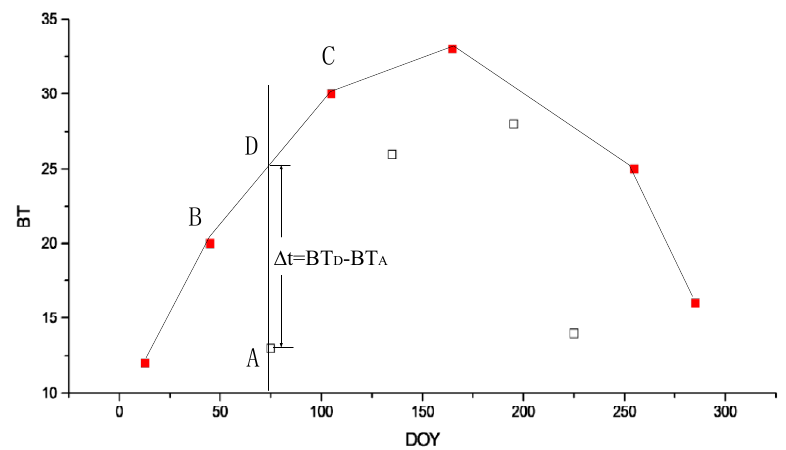
Figure A3. Map of sunny day screening.